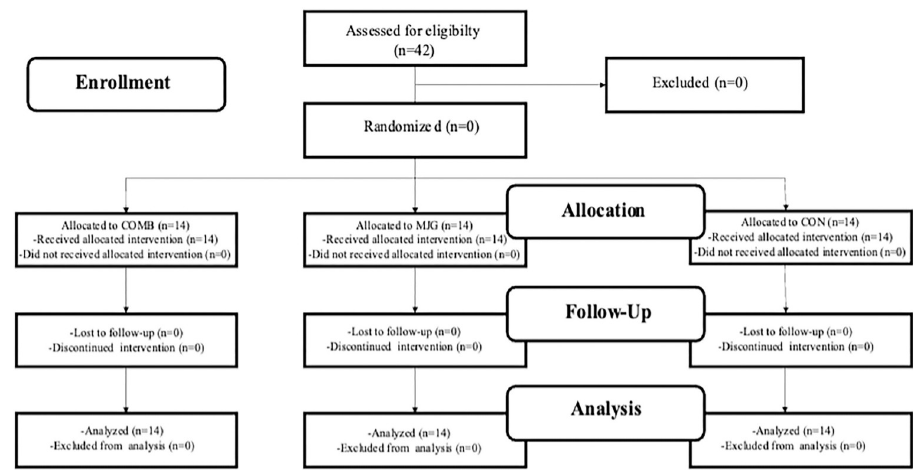
Fig 1. Flow chart of the progress through the phases of the study according to the CONSORT